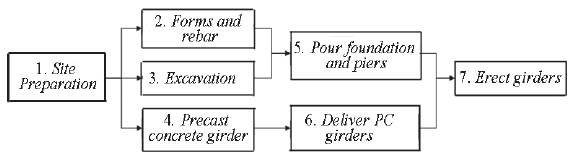
axisFig. Fig. 7. Description of chromosome